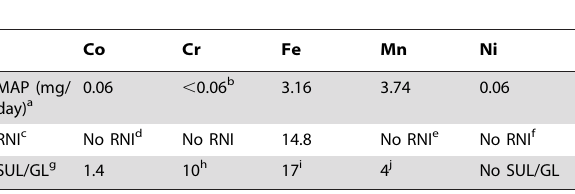
Table 7. MAP values of five mineral elements following the consumption of 20 g of Calabash chalk by human geophagists, and a comparison with: (I) RNI values for adolescent 15–18 year old females and women of child- bearing age, and (II) SULs/GLs for a 60 kg